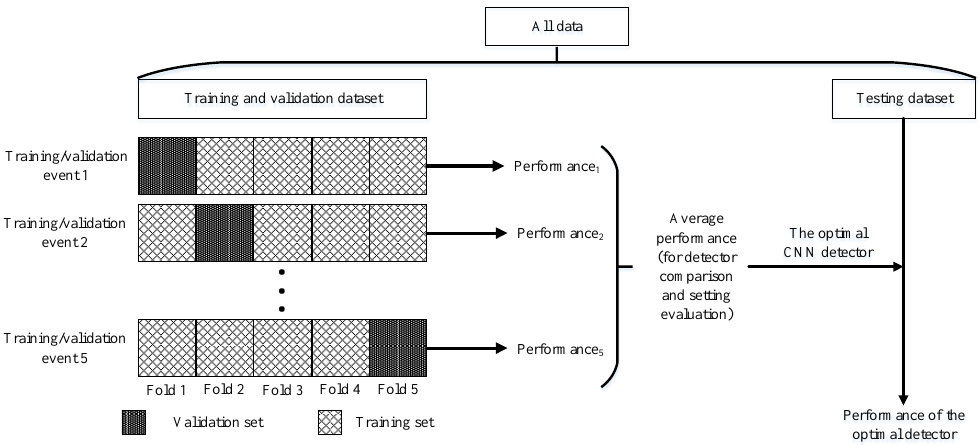
Figure 3. Illustration of the training, validation, and testing process. CNN means convolutional neural network. Performance includes precision, recall, accuracy, RMSE, and processing speed.